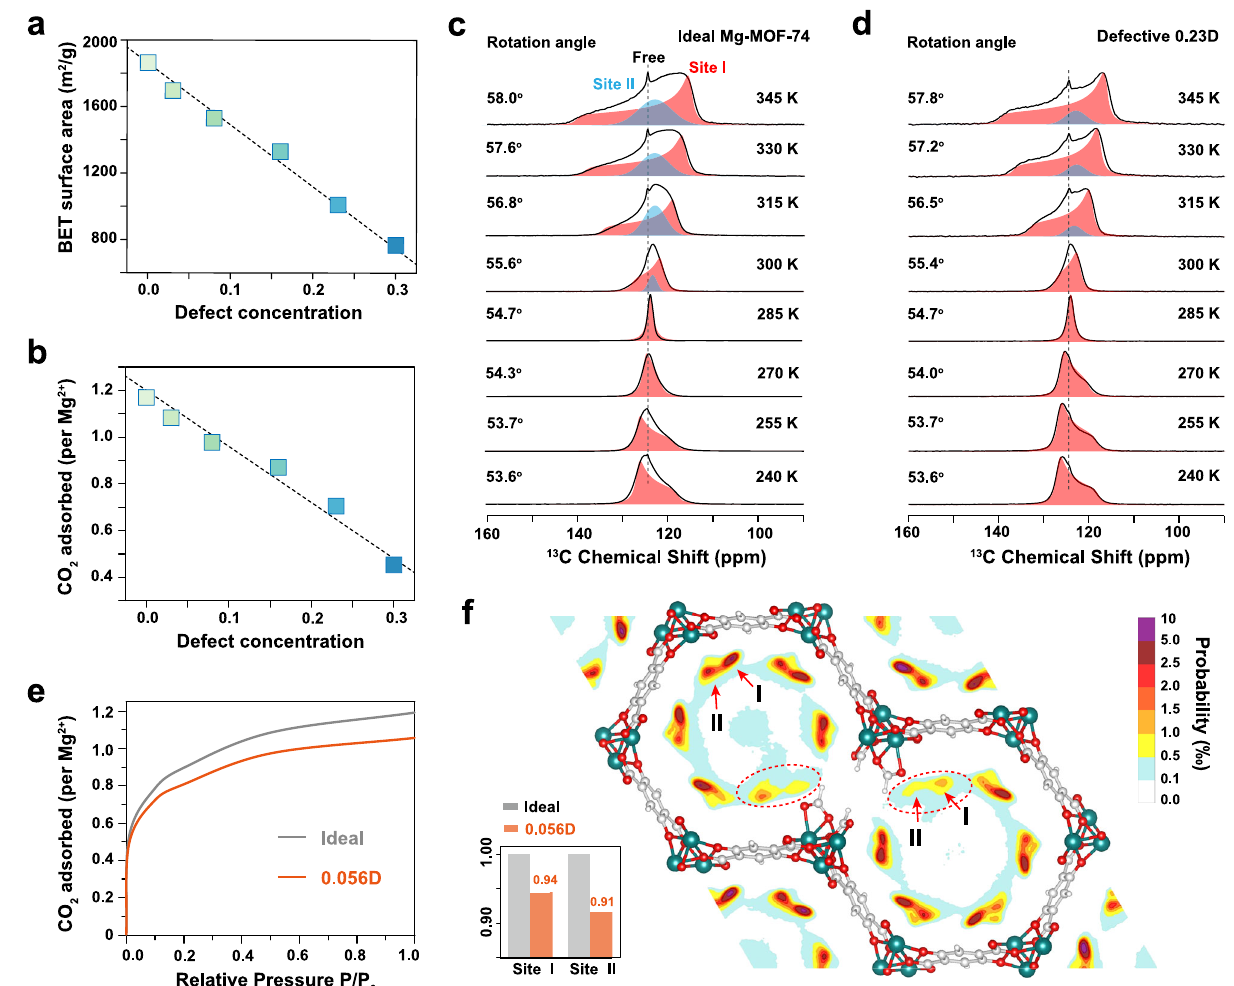
Fig.3|ThegasadsorptionmechanismsinMg-MOF-74.a TheBETsurfaceareasof Mg-MOF-74withvariousdefectconcentrations.Thedashedlinecorrespondstothe temperatures. The red patterns are the simulated CSA lineshapes of CO 2 uniaxial rotationwithcorrespondingrotationalangles(attributedtotheadsorptionatsiteI). ThebluepatternsareGaussianlineshapesfortheCO 2 adsorptionatsiteII.Avertical